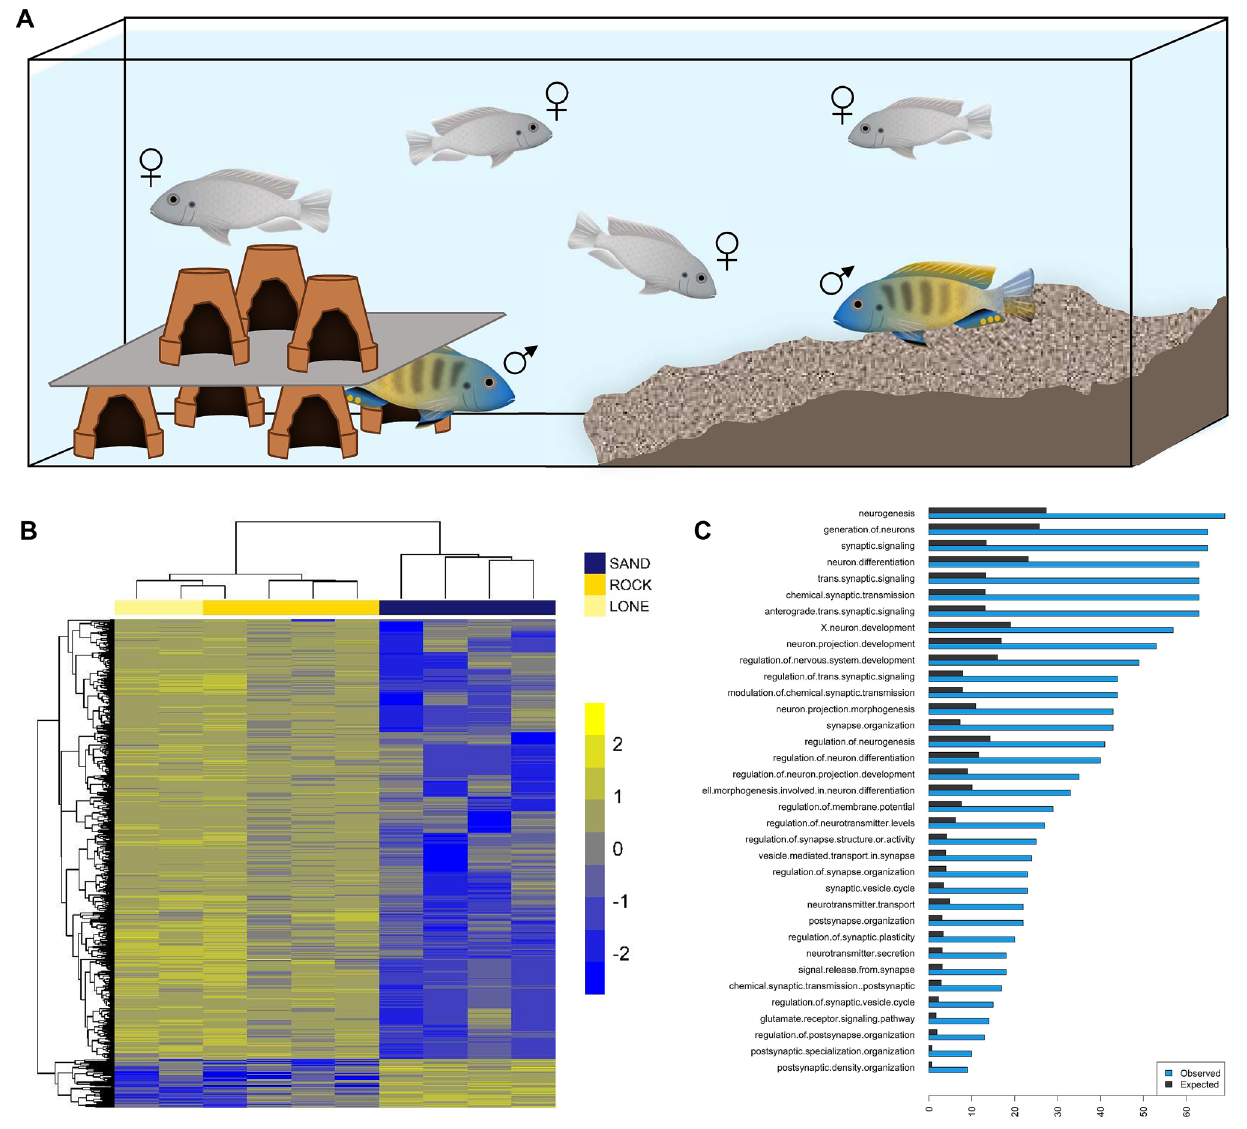
Figure 3. Genomics of divergent social context. ( A ) Schematic of the social context behavioral paradigm, in which rock-, sand- and rock-X sand-F 1 hybrids were evaluated. ( B ) Heatmap of genes (ggplot2 v3.3.3 https:// ggplo t2. tidyv erse. org/) differentially expressed in the brains of F 1 males behaving in either rock or sand social contexts. Each row in the heatmap is a gene, each column is an individual. R individuals are socially rock, S individuals are socially sand and the numbers indicate sibling pairs. Two F 1 males were not paired with other males, and courted females over the rock habitat (lone). All other F 1 males (n = 8) were introduced to the testing arena in dyads. Notably, male brain gene expression clusters by social context and not fraternal relationships. ( C ) Gene Ontology (GO) Biological Process terms that show greater than expected overlap between (i) genes differentially expressed in the brains of social rock- vs. social sand-males and (ii) genes that are differentiated in the genomes of rock- vs sand-species expectation, there is clear clustering of genome divergence on chromosome 11 for the pit-castle comparison (Supplementary Fig. S6), while all chromosomes carry the signature of rock-sand diversification (Fig. 1B). How- ever, contrary to our expectation, rock- vs. sand- and pit- vs. castle-radiations have diverged in similar gene sets. Out of 3070 genes identified near 10 kb high F ST regions in the rock- vs. sand-comparison, 483 overlap with 1090 genes identified near high F ST regions in the pit- vs. castle-comparison (p-value < 2e−9, Fisher’s exact test, Supplementary Table S4). This result may imply that evolutionary diversification in Lake Malawi is limited, or constrained, by chromosomal location. Overall, genes in proximity to rock-sand divergent variants were enriched for functional categories related to early forebrain and craniofacial development, neuronal function and social behavior. This list of variants, coupled with consistent patterns of functional and pathway enrichment, motivated follow up experiments focused on early brain development and adult social behavior (Fig. 4). It is apparent from our work here and previously 25,26 ,